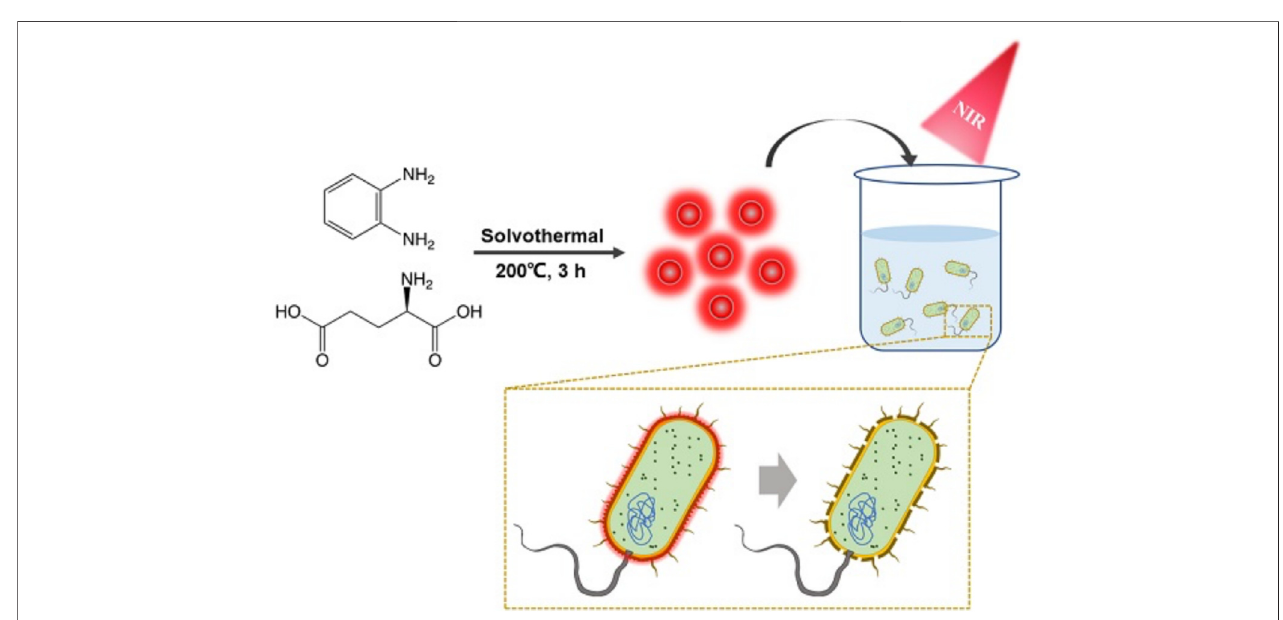
FIGURE 1 | Schematic illustration of synthesis of the BAPTCD mechanism of bacteria targeting and photothermal ablation of BAPTCDs upon laser irradiation.